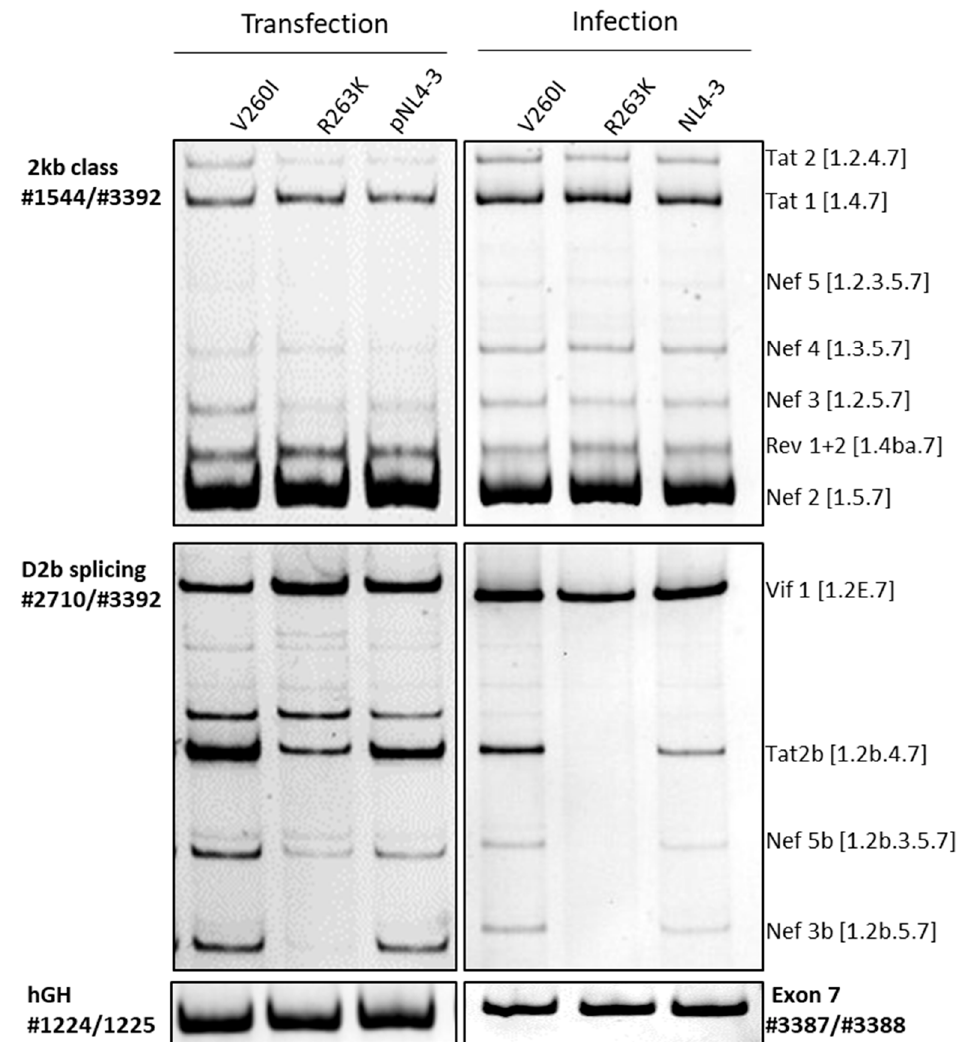
Figure 2 . Effects of secondary drug resistance-associated mutations on the HIV-1 splicing pattern. Left panel: Proviral plasmids were used for transfection as wildtype (pNL4-3) or carrying either the V260I or R263K mutation. 2.5 × 10 5 Hek 293T cells were transiently transfected with 1 μ g of each construct together with 1 μ g of pXGH5 (hGH) to monitor transfection efficiency. Then, 24 h after transfection, RNA was isolated and subjected to RT-PCR analysis using different primer pairs (#1544/#3392 for 2kb class, #2710/#3392 for D2b splicing, #1224/#1225 for hGH). PCR products were separated by a 10% non-denaturing polyacrylamide gel electrophoresis and stained with ethidium bromide. Right panel: 1.0 × 10 6 PM1 cells were infected with either wildtype or mutant virus (MOI 0.05). RNA was harvested 72 h post-infection, and RT-PCR was performed with the same primer pairs as for transfection except for the control (#3387/#3388 for Exon 7). Again, PCR products were separated by a 10% non-denaturing polyacrylamide gel electrophoresis and stained with ethidium bromide. The main difference between the splicing patterns can be seen for R263K D2b splicing where the Tat 2b, Nef 5b, and Nef 3b messages are lost upon infection. Experiments were performed as individual triplicates.